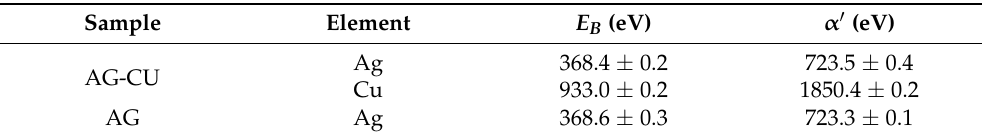
Figure 2. ( a ) Ag 3d and ( b ) Cu 2p electron energy region spectra of samples. Table 2. Summary of binding energy ( E B ) and modified Auger parameter (α′ ) values of samples (mean ± SD).